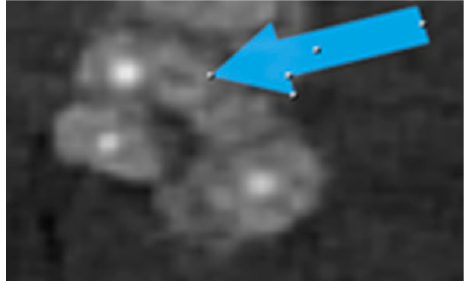
Figure 5. E—the teeth subjected to successful endodontic treatment.